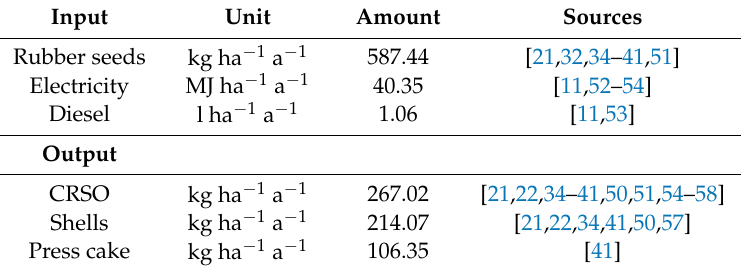
Table 2. CRSO extraction inputs and